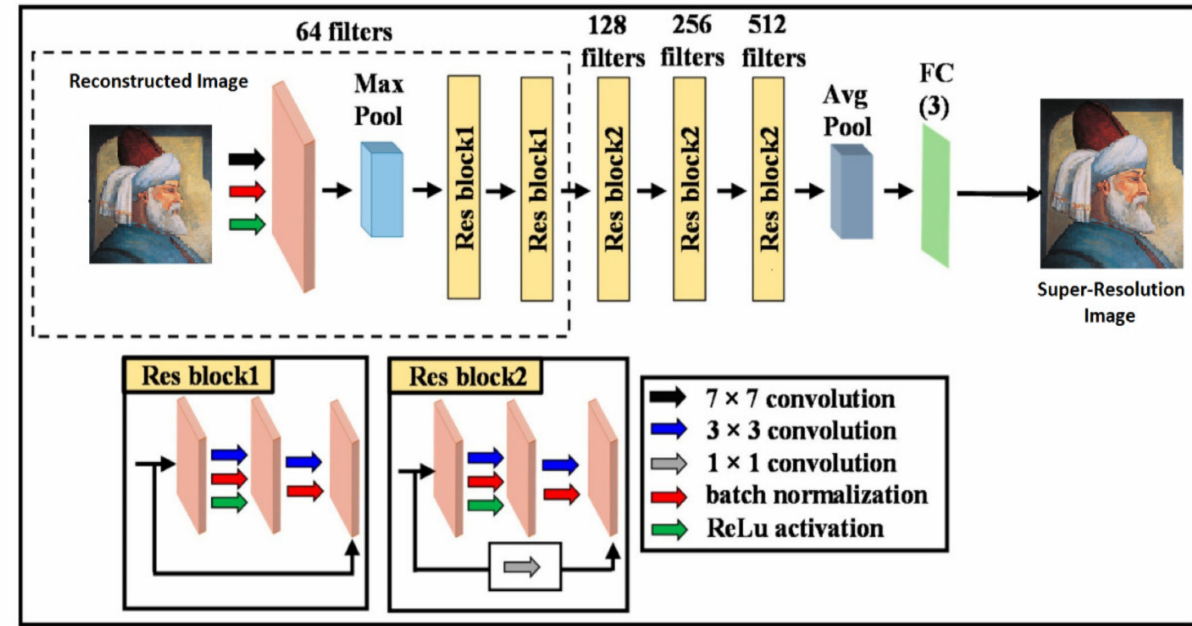
Figure 11. Visual representation of ResNet-based CNN